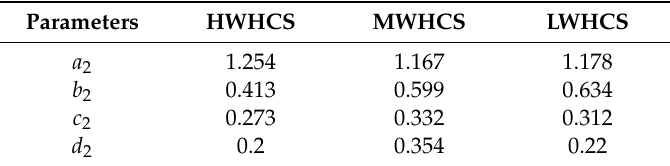
Table 5. Ternary fitting parameters for three soil